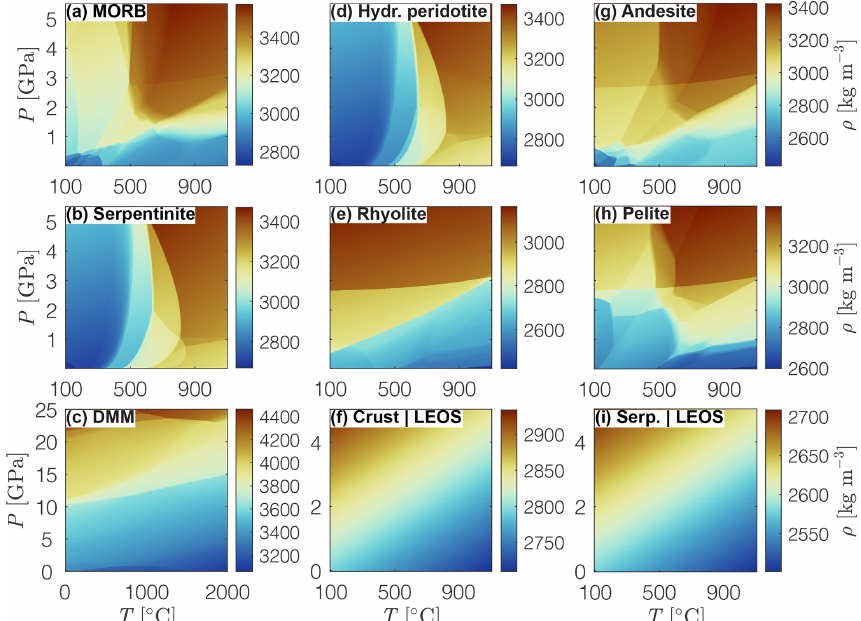
Figure 3. Density structures employed in the models presented here. (a–e, g–h) Phase diagram density fields calculated with Perple_X for the bulk rock compositions given in Table 2. (f, i) Density fields calculated using a linearized equation of state (Eq. A3) for an upper crustal reference density of 2800kgm − 3 and a serpentinite reference density of 2585kgm − 3 ,